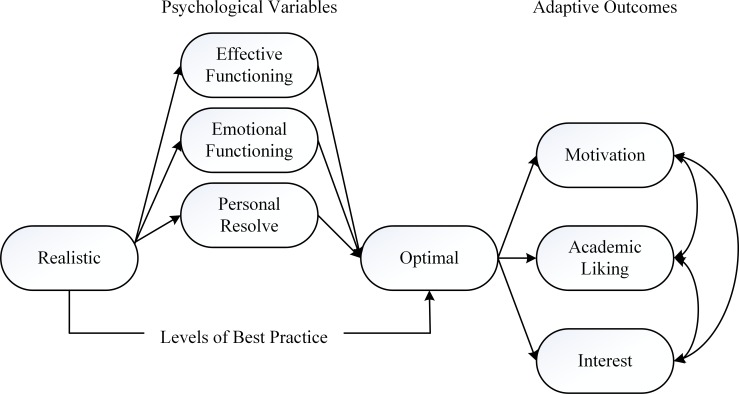
Conceptual model.